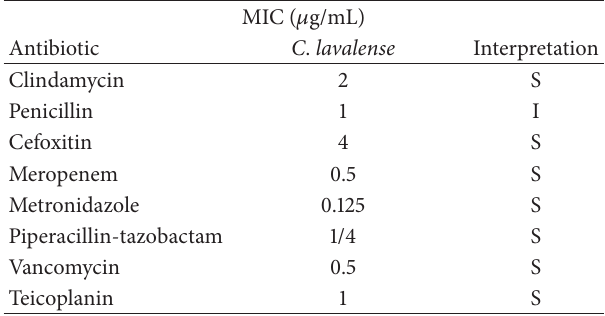
Table 1: MICs of selected antibiotics for C. lavalense